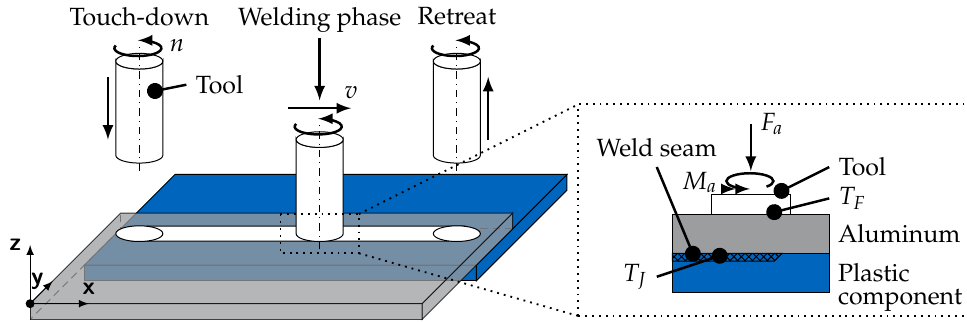
Figure 1. The friction press joining process with its forces and temperatures during the process (based on